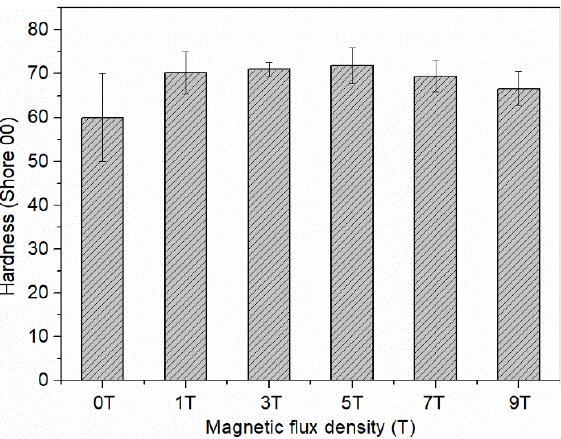
Figure 10. The hardness (shore 00) of the CF–rubber composites applied with different magnetic flux density.